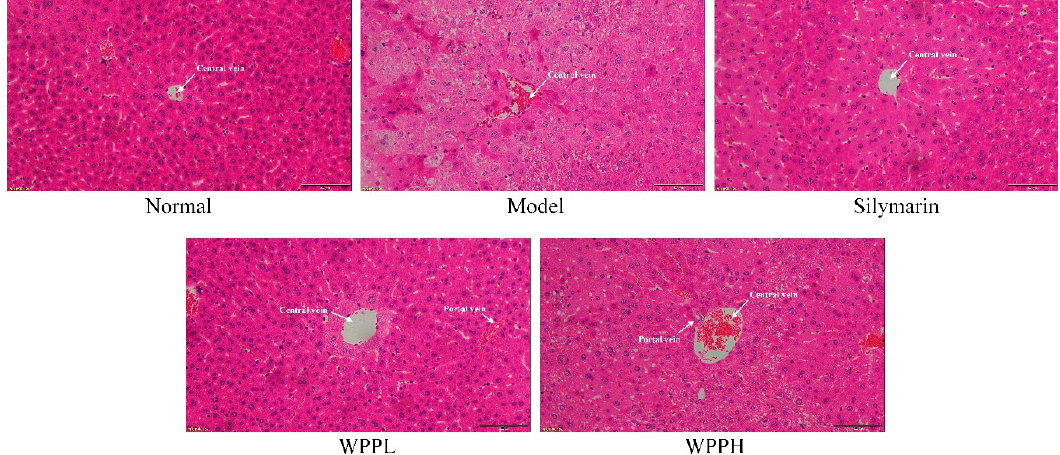
Figure 3. Hematoxylin and eosin staining of hepatic tissues from mice. Magnification 100×. Silymarin: mouse treated with 100 mg/kg silymarin; WPPL: mouse treated with 50 mg/kg white peony polyphenols; WPPH: mouse treated with 100 mg/kg white peony polyphenols.